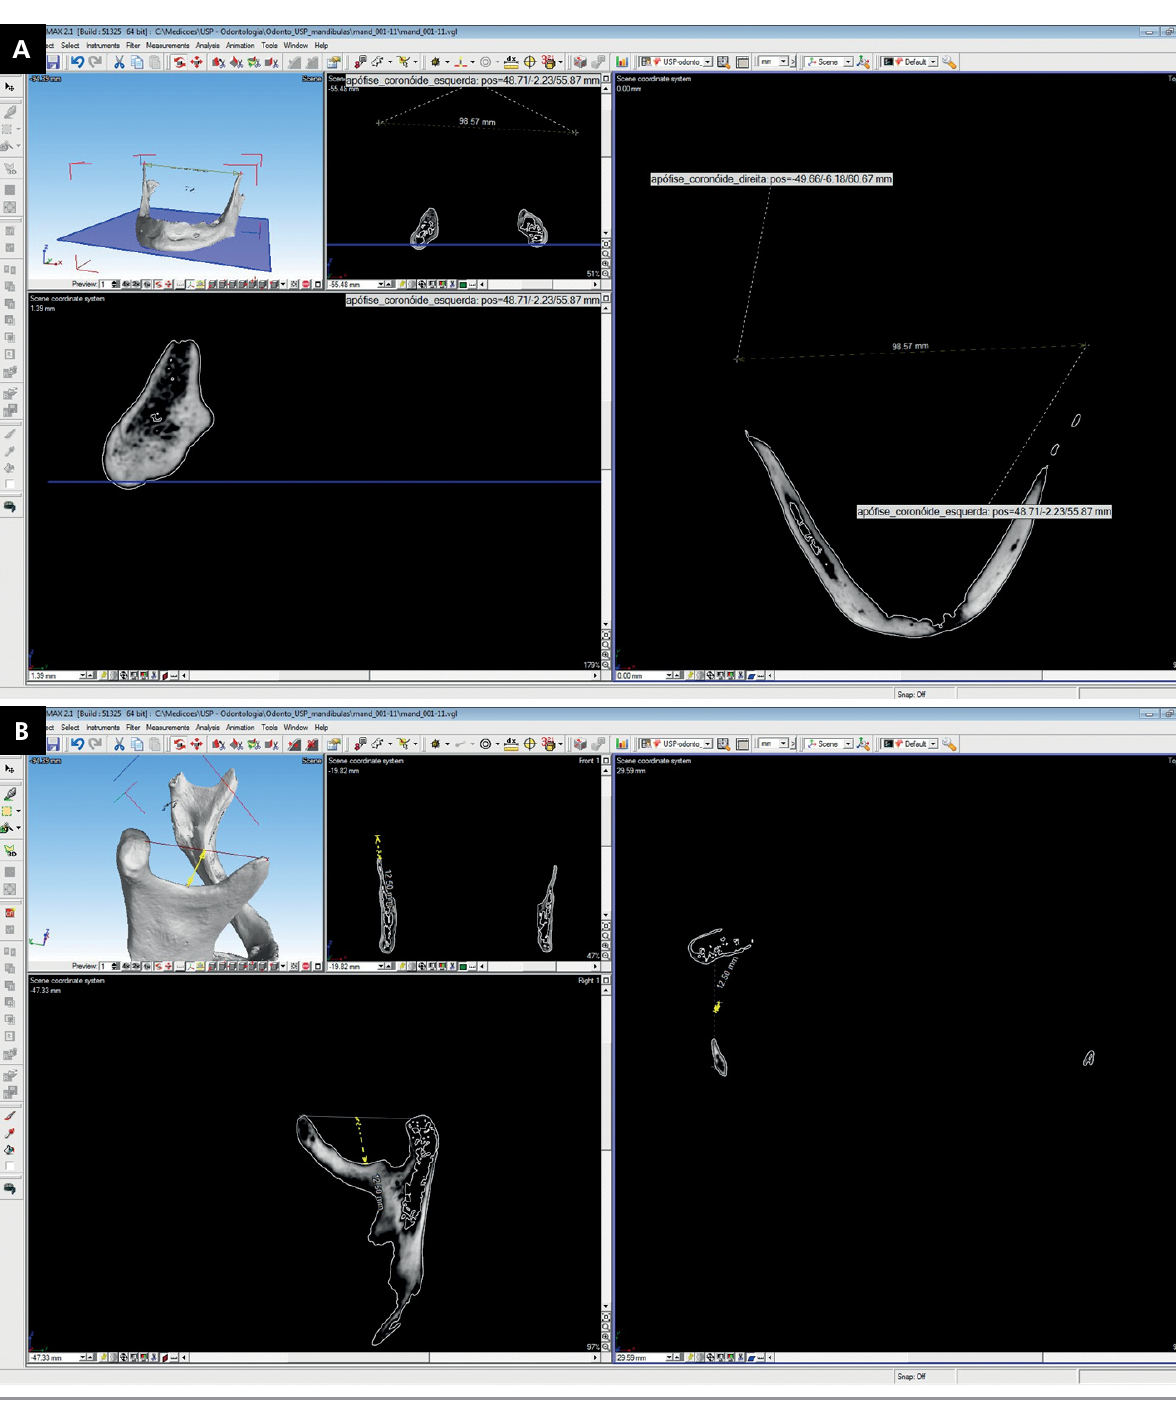
Figure 1. CT mandible images (gold standard). 1a: bicoronoid breadth; 1b: mandibular notch